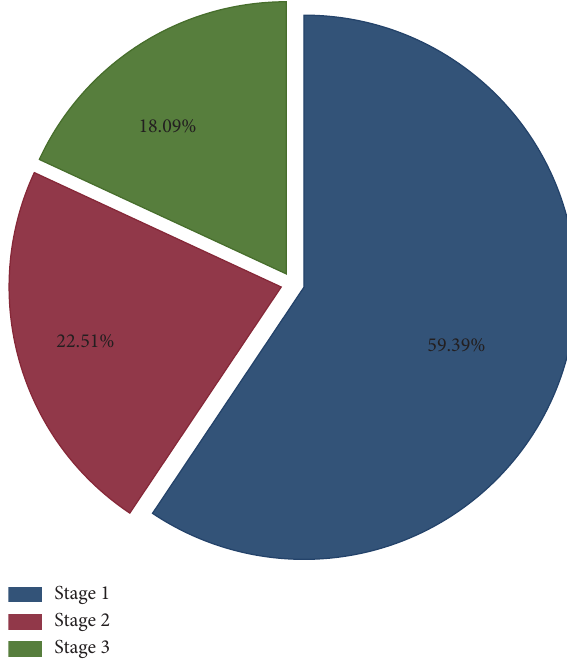
Figure 1: AKI by AKIN